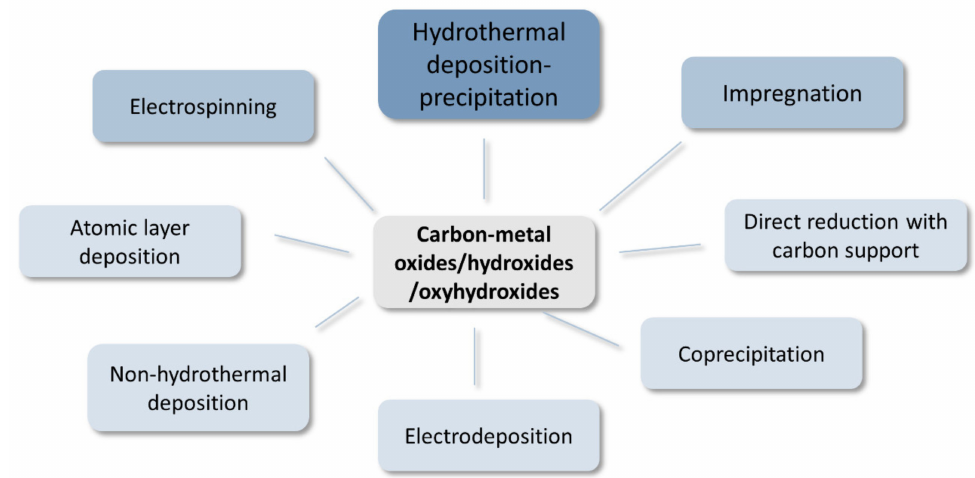
Figure 5. Graphical summary of synthesis methods of carbon–metal